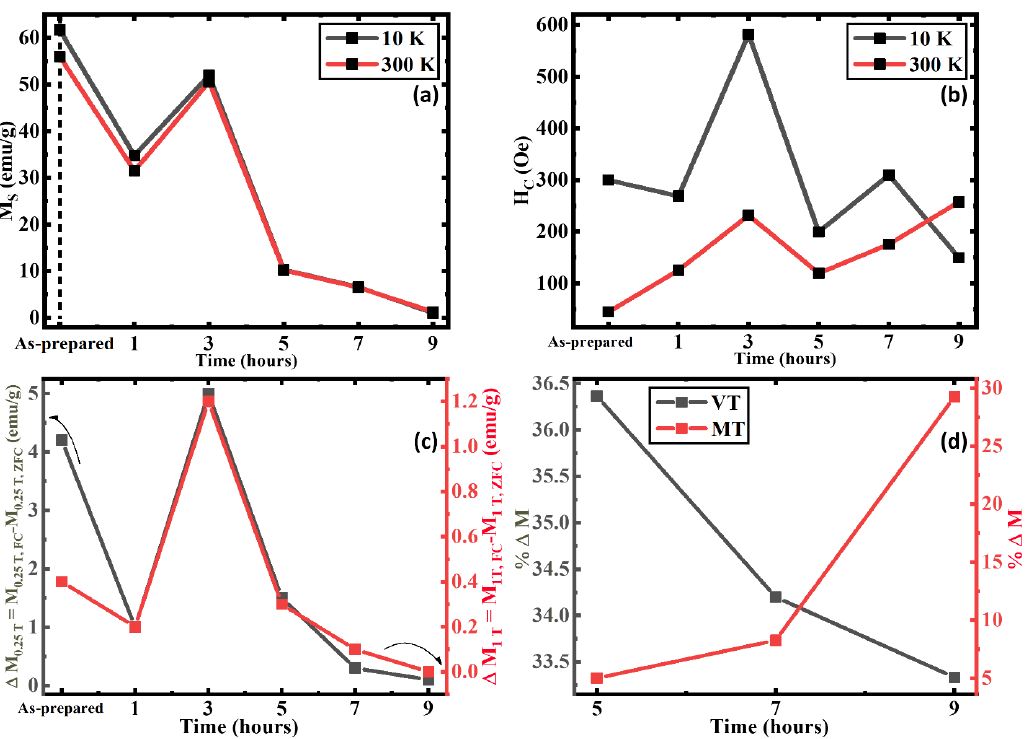
Figure 6. ( a ) Maximum magnetization at 1 T, ( b ) Coercivity at 10 K and 300 K, ( c ) Difference between the FC and ZFC magnetization at 10 K on 0.25 T and 1 T applied field of iron oxide nanorods, and ( d ) Percentage change in magnetization around VT and MT of 5, 7, and 9 h annealed iron oxide nanorod samples.